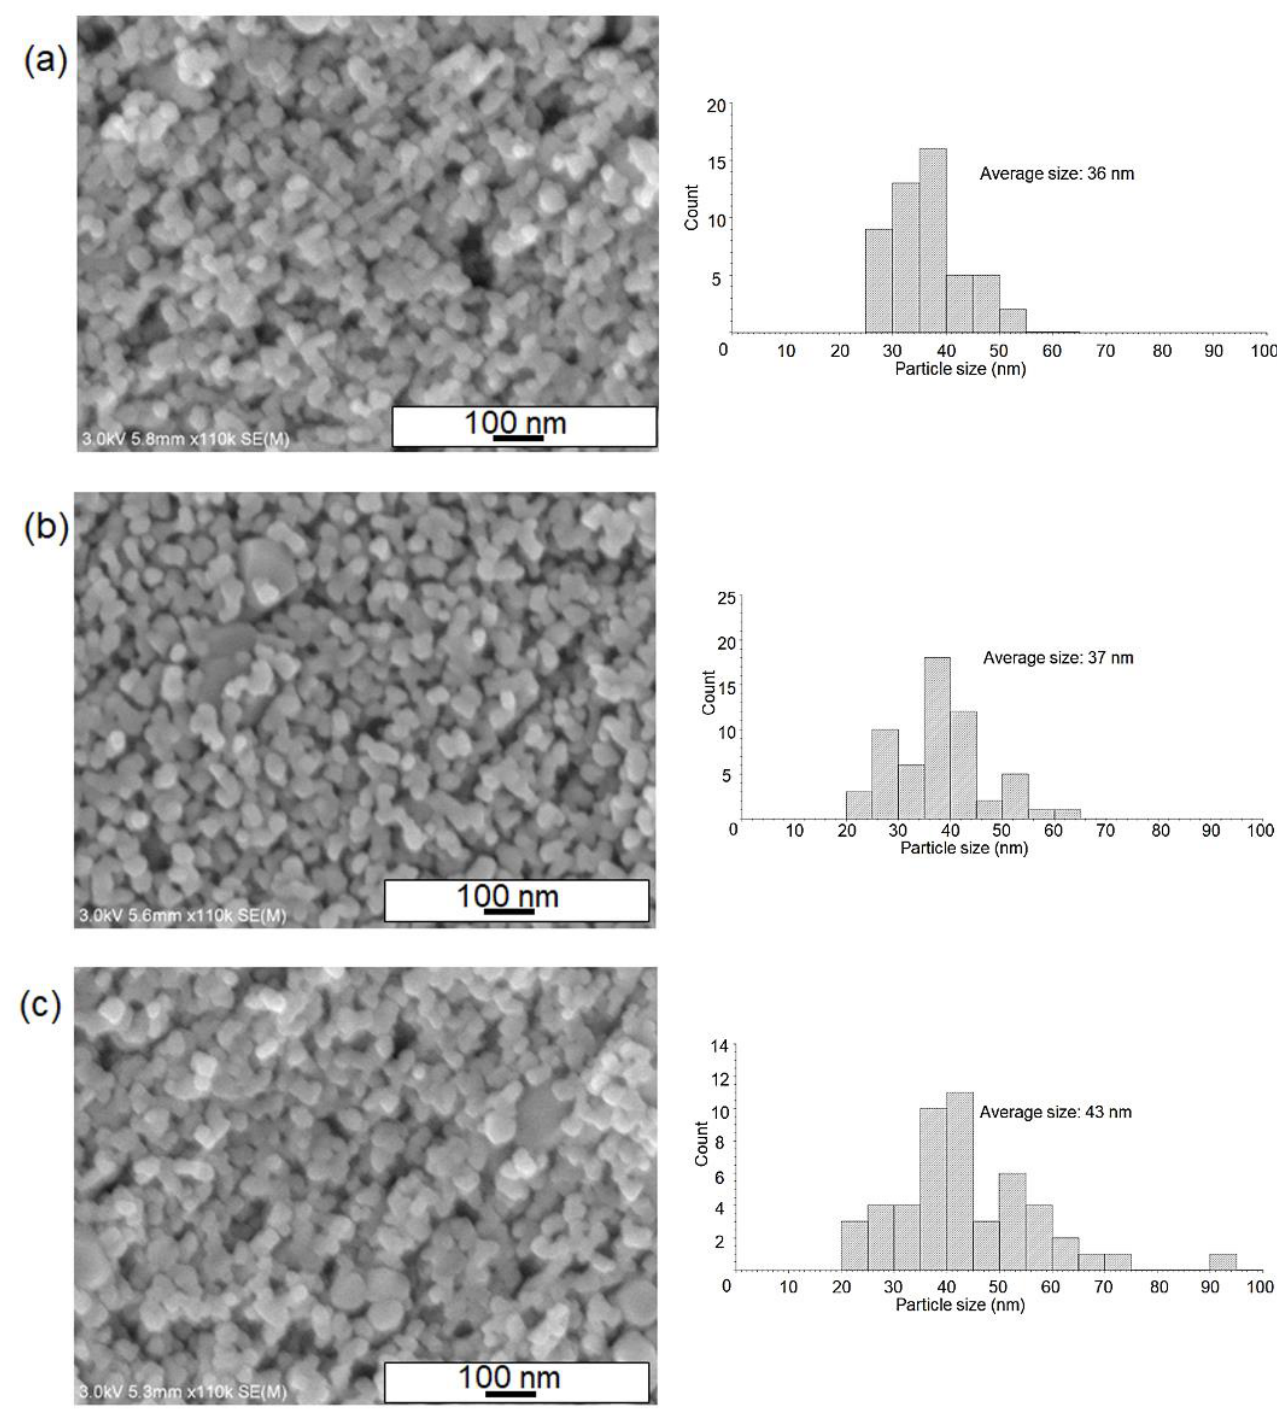
Figure 5. SEM images of the surface of TiO 2 films after nanofluid pool boiling, where the post-sintering strategies have been changed. Sintering strategies (maximum temperature, ramping rate, and the period of maximum temperature): ( a ) 550 °C, 1 °C/min, 1 h, ( b ) 550 °C, 1 °C/min, 6 h, ( c ) 550 °C, 15 °C/min, 1 h. Particle size distributions of the nanoparticles were also presented.